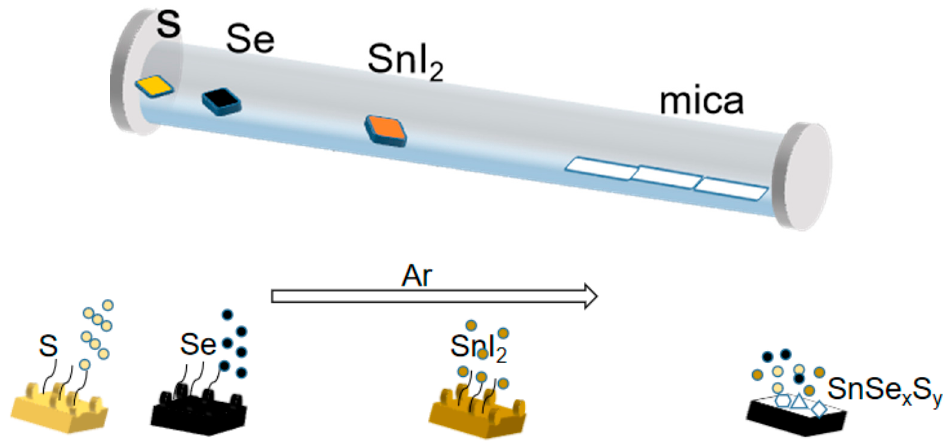
Figure 1. Experimental process for preparing SnSe x S y nanosheets.